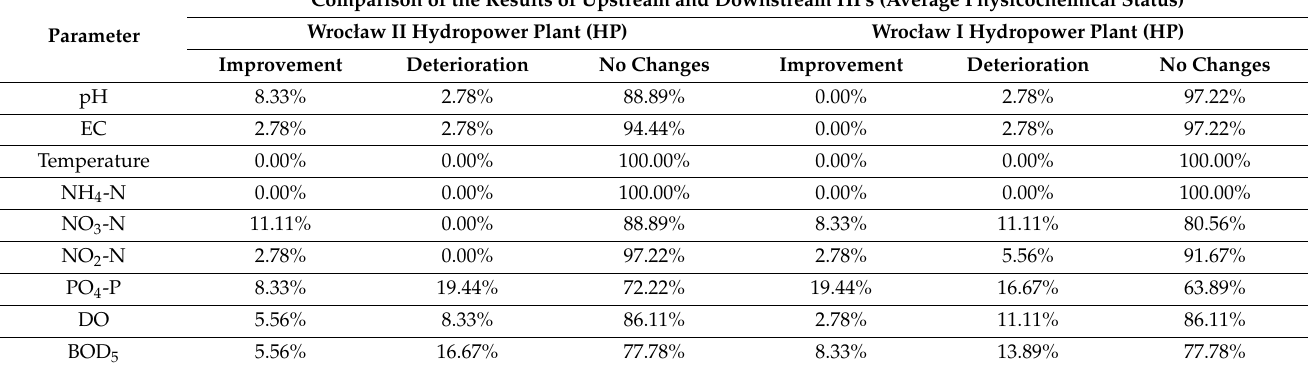
Table 9. Detailed summary of the results of the average physicochemical status within the Wrocław I and Wrocław II hydropower plants.